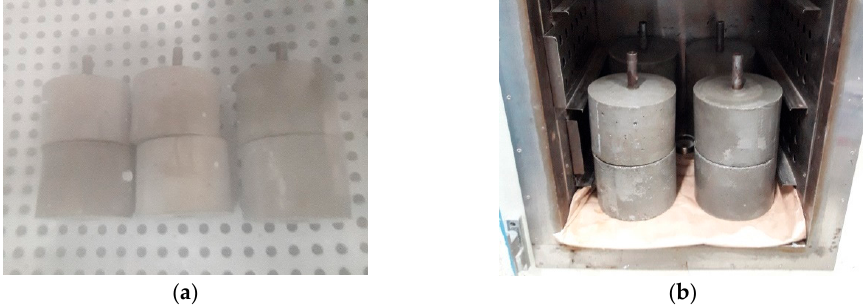
Figure 3. Mortar section preparation for surface conditioning ( a ) curing in water chamber; ( b ) placement in desiccator chamber.